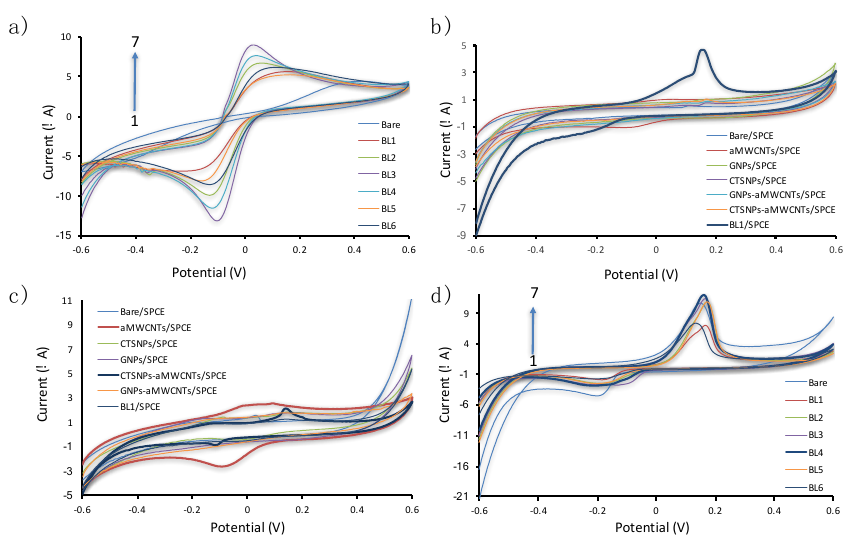
Figure 3. ( a ) Cyclic voltammograms of 1.0 mM K 3 Fe(CN) 6 and 0.1 M KCl at bare SPCE (1), BL5/SPCE (2), BL1/SPCE (3), BL6/SPCE (4), BL2/SPCE (5), BL3/SPCE (6), and BL4/SPCE (7) at a scan rate of 0.05 V/s. ( b ) Cyclic voltammetry (CV) curves of Bare/SPCE, aMWCNTs/SPCE, gold nanoparticles (AuNPs)/SPCE, chitosan nanoparticles (CTSNPs)/SPCE, AuNPs-aMWCNTs/SPCE, chitosan nanoparticles-activated multi-walled carbon nanotubes (CTSNPs-aMWCNTs)/SPCE BL1/SPCE in 0.2 M citrate buffer solution (CBS) with 10 µ M quinoline and ( c ) without quinoline. ( d ) Cyclic voltammograms of 10 µ M quinoline at bare/SPCE (1), BL1/SPCE (2), BL2/SPCE (3), BL5/SPCE (4), BL6/SPCE (5), BL3/SPCE (6), and BL4/SPCE/SPCE (7) in 0.2 M CBS at a scan rate of 0.05 V/s. The acronym BLn/SPCE is used to refer